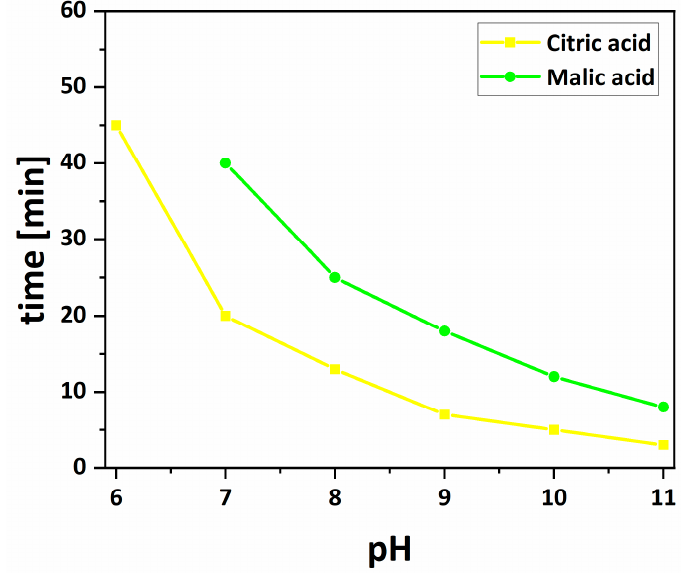
Figure 9. The dependence of time after which the reaction was observed as a function of pH for silver nanoparticles reduced by citric and malic acids.